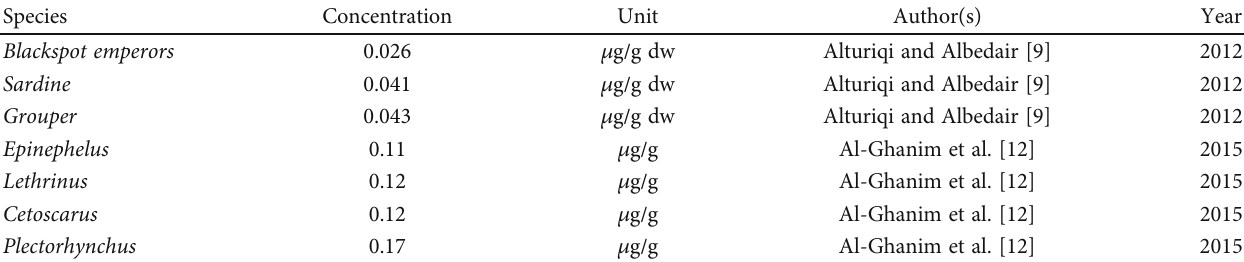
Table 8: Bioaccumulation of mercury reported from the Red Sea.